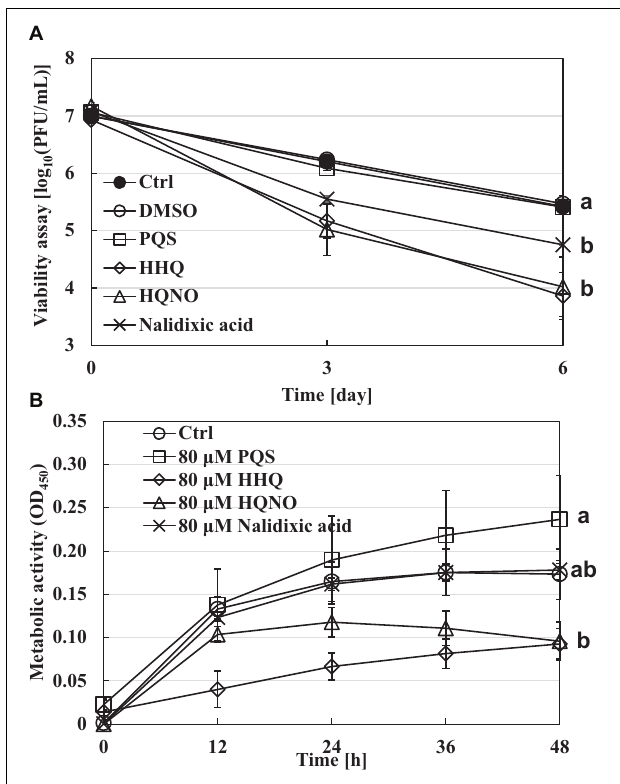
FIGURE 5 | Effect of each quinolone compound itself on the viability of Bdellovibrio bacteriovorus cells. (A) The dynamics of viable cells of B. bacteriovorus in HEPES buffer with or without 80 µ M of PQS/HHQ/HQNO/nalidixic acid. The incubation was conducted for 6 days at 30 ◦ C and 120 rpm under aerobic condition. n = 2. (B) The metabolic activity of B. bacteriovarus cells with or without 80 µ M of PQS, HHQ, HQNO, or nalidixic acid for 48 h at 30 ◦ C left to stand in LB medium. “Ctrl” means a mixture of B. bacteriovorus cells and DMSO as a control solvent. PQS, Pseudomonas quinolone signal, 2-heptyl-3-hydroxy-4(1H)-quinolone; HHQ, 2-heptyl-4-quinolone; HQNO, 2-heptyl-4-quinolinol 1-oxide. n = 3. The value among each sample with different letters is significantly different ( p <